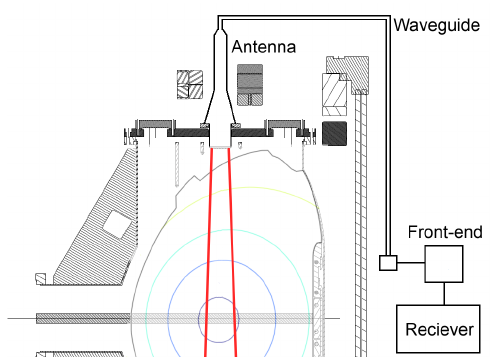
Figure 2. Scheme of the V-ECE measurement setup.